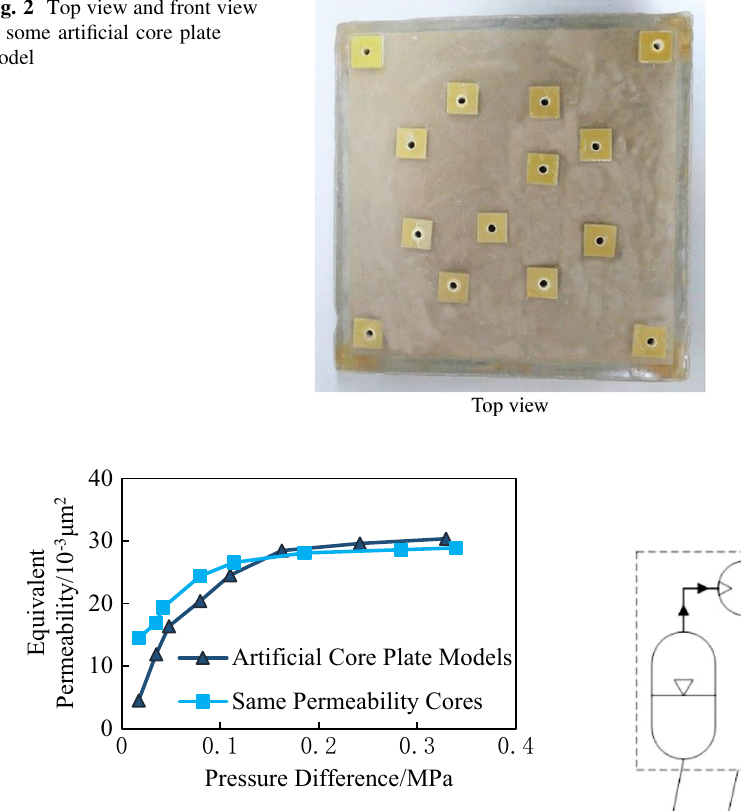
Fig. 3 Relationship between pressure difference and equivalent permeability of artificial core plate model and cores from low- permeability reservoir